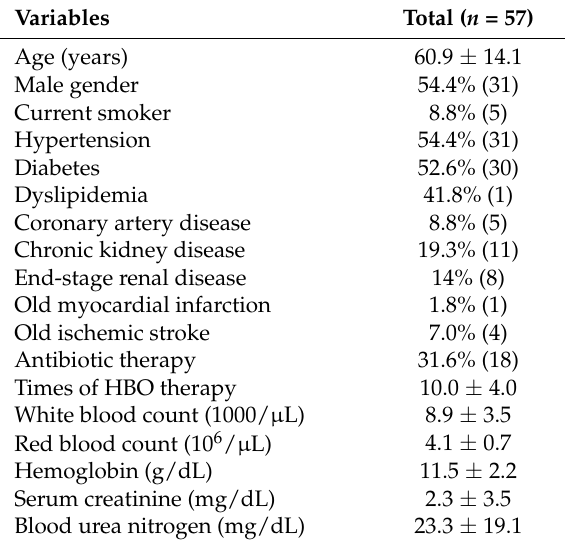
Table 1. Baseline characteristics among the patients receiving HBO